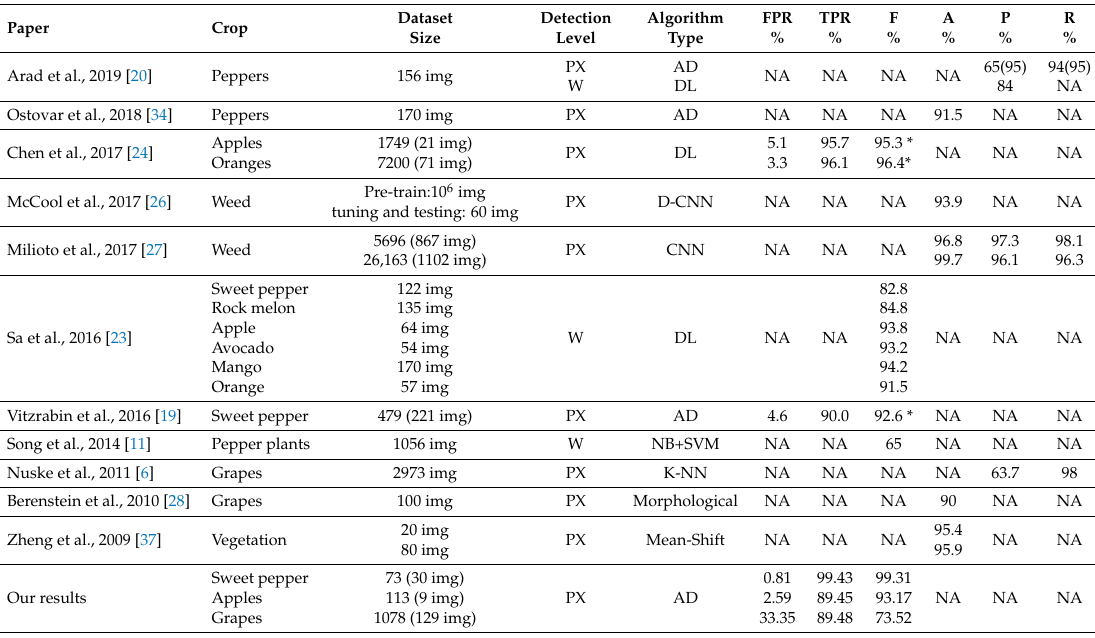
Table 1. Summary of previously-published